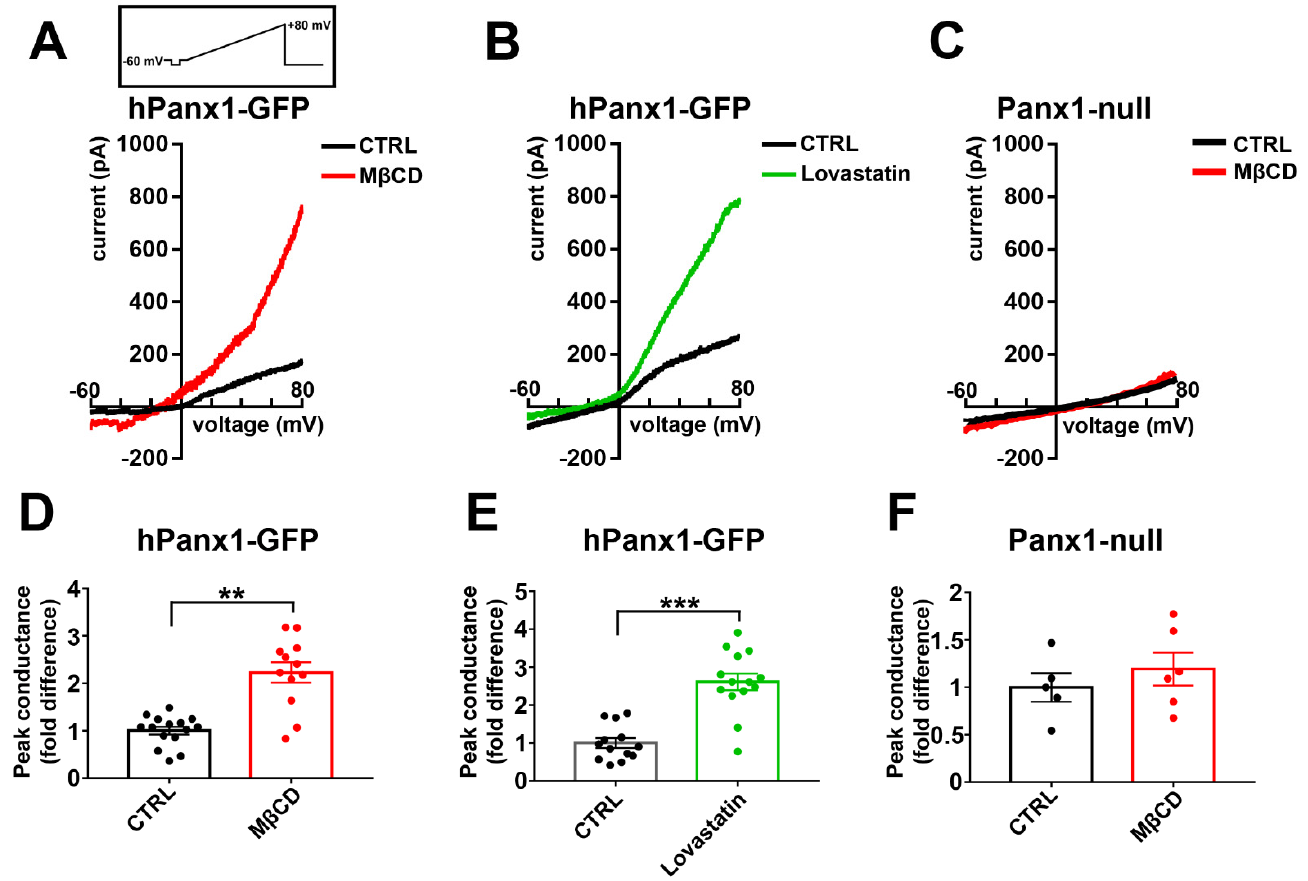
Figure 9. Human Panx1 conductance is activated by cholesterol depletion. ( A , B ) Electrophysiological recordings obtained from N2a cells expressing hPanx1 subjected to treatment with 5 mM M β